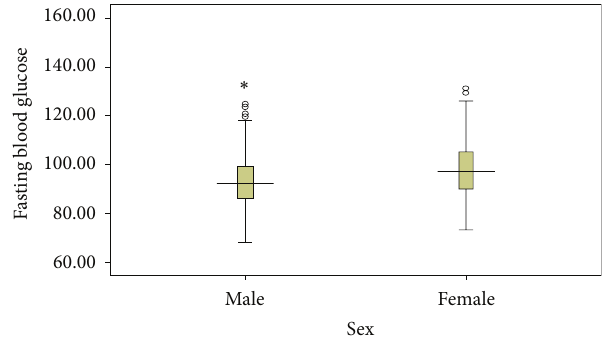
Figure 2: Comparison of FBG (mg/dL) pattern in male and female population.